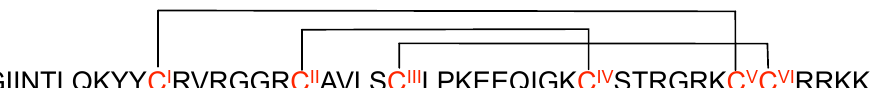
Figure 1. Sequence and disulfide bond connectivity of native HBD-3. Respective Cys residues (red color) are identified with roman numbers .